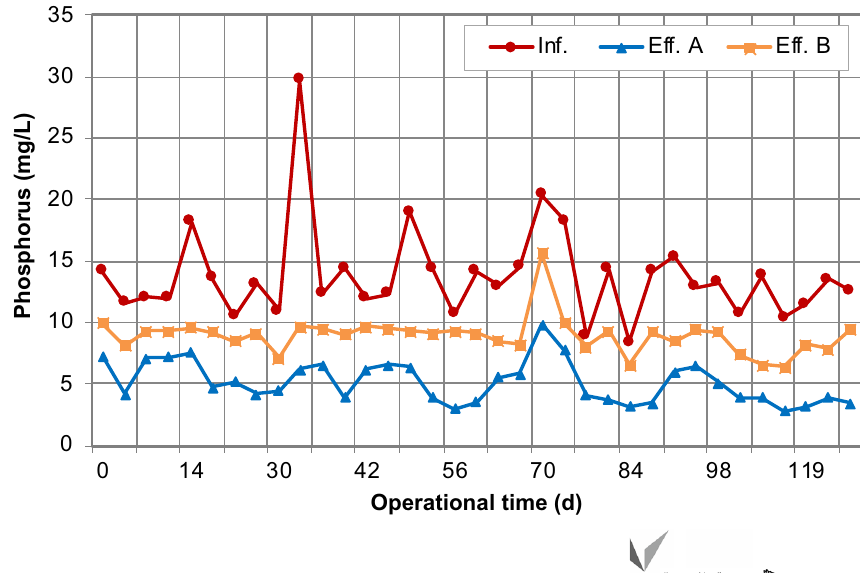
Fig. 9 Profile of influent–efflu- ent phosphorus concentration for SBR A and SBR